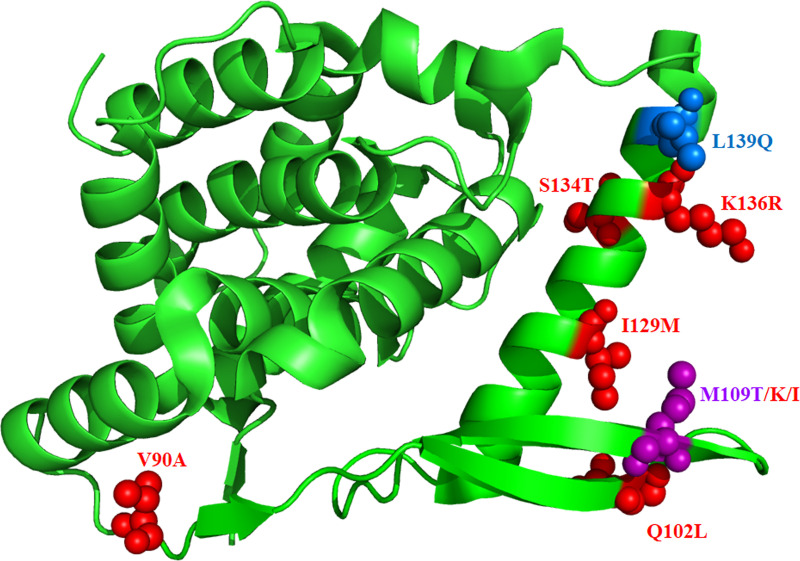
Locations of mutations mapped to RSV-A N protein.Crystal structure of amino acids 32–251. RSV-A mutations shown in red, RSV-B mutations shown in blue, purple indicates mutation seen in both. PDB file 4UC6 used for this analysis.